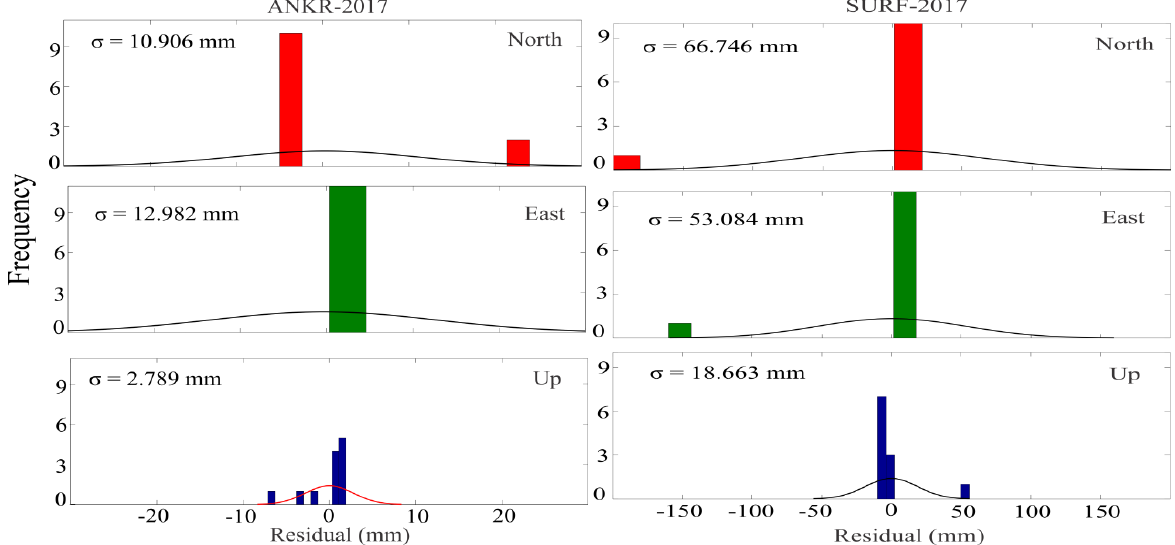
Figure 3: The coordinate reliability of GNSS sites from the year 2009 to